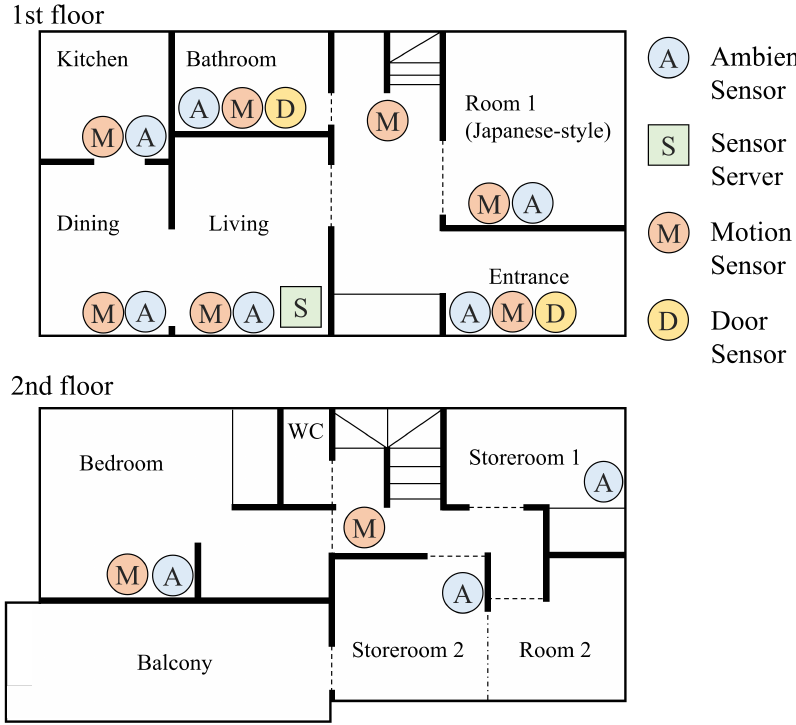
Figure 11. Floor plan of the target of proposed system (a selected